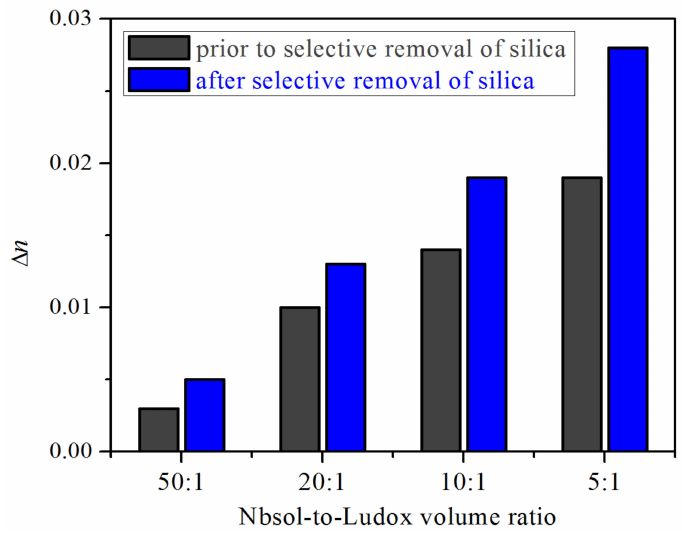
Figure 8. Refractive index change due to acetone vapor absorption prior to and after selective removal of silica in hard-templated films of Nb 2 O 5 obtained by liquid phase mixing of Nb sol and silica colloids in different volume ratios indicated in the figure. The films were etched in a standard SiO 2 etcher for different times: 240 s for the 50:1 and 20:1 films, 210 s for the 10:1 film and 120 s for the 5:1